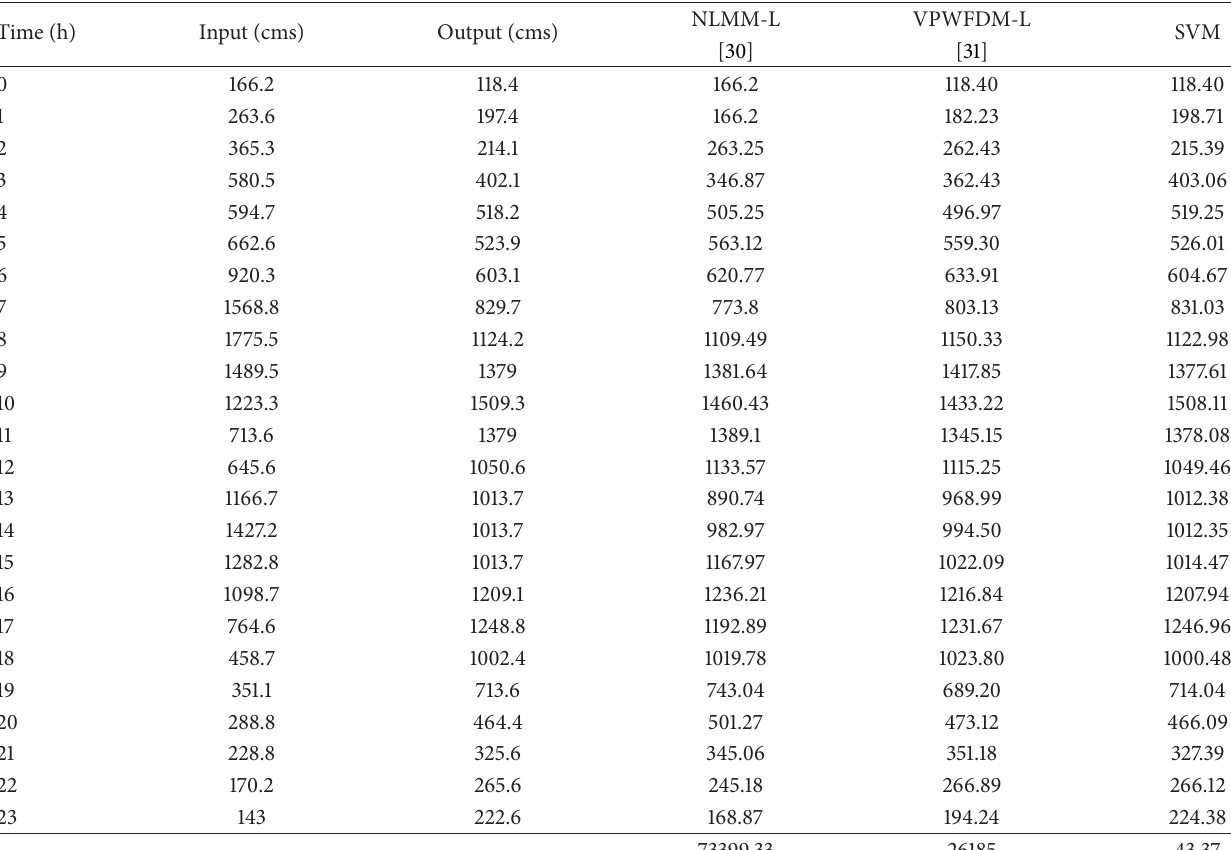
Table 2: Comparison of the observed and routed outflows for Viessman and Lewis